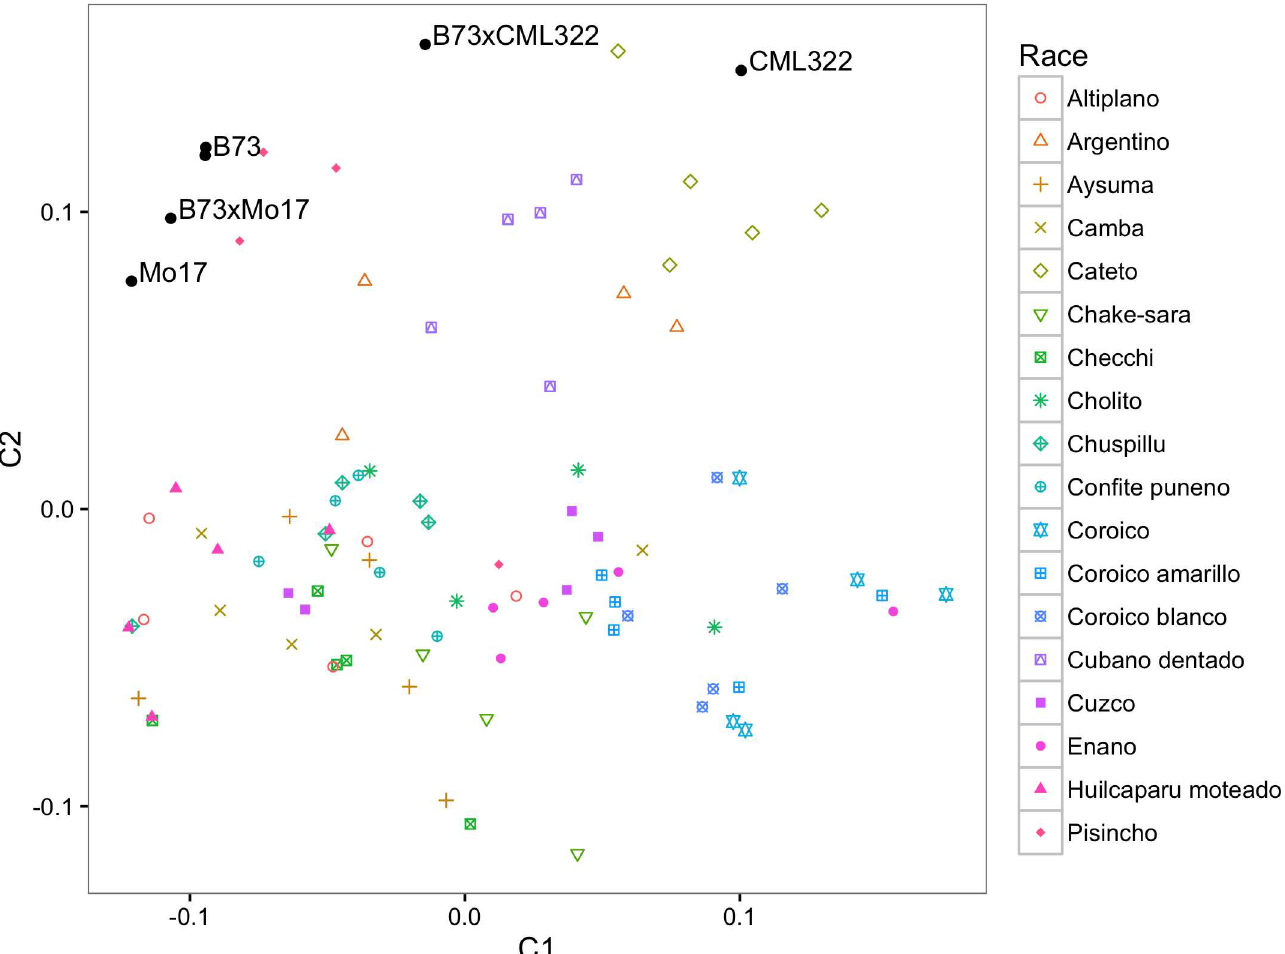
Fig 5. Multidimensional scaling applied to all samples at all resequenced loci. The plot includesfive samplesper accession and control